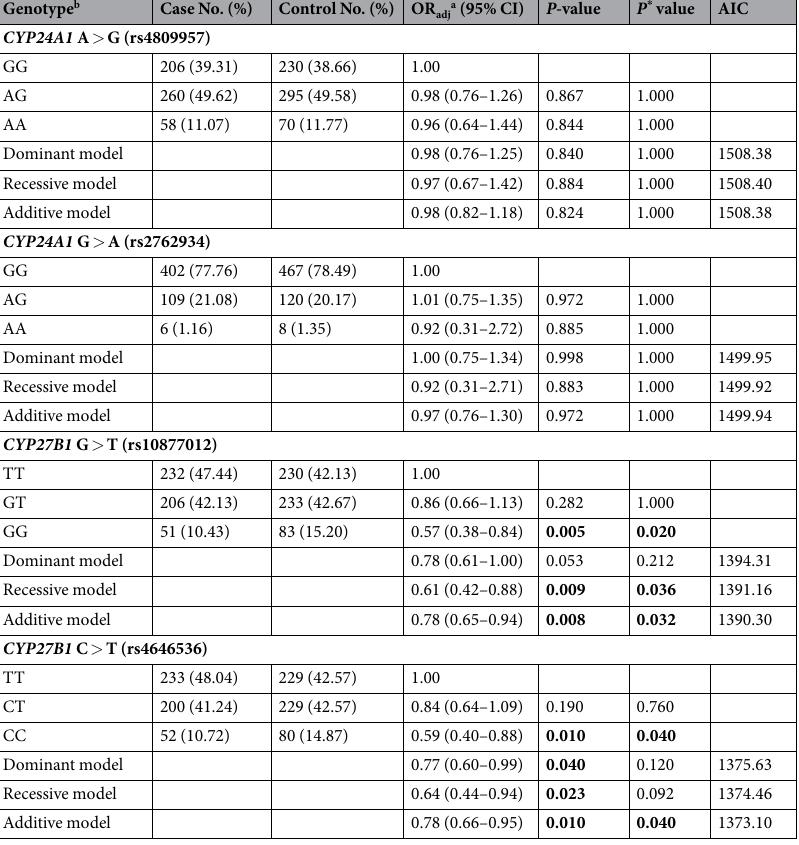
Table 2. Associations between the polymorphisms in CYP24A1 , CYP27B1 and the risk of colorectal cancer. a OR: odds ratio; CI: confidence interval. OR b missing values: rs4809957, adj : adjusted by age, and BMI.